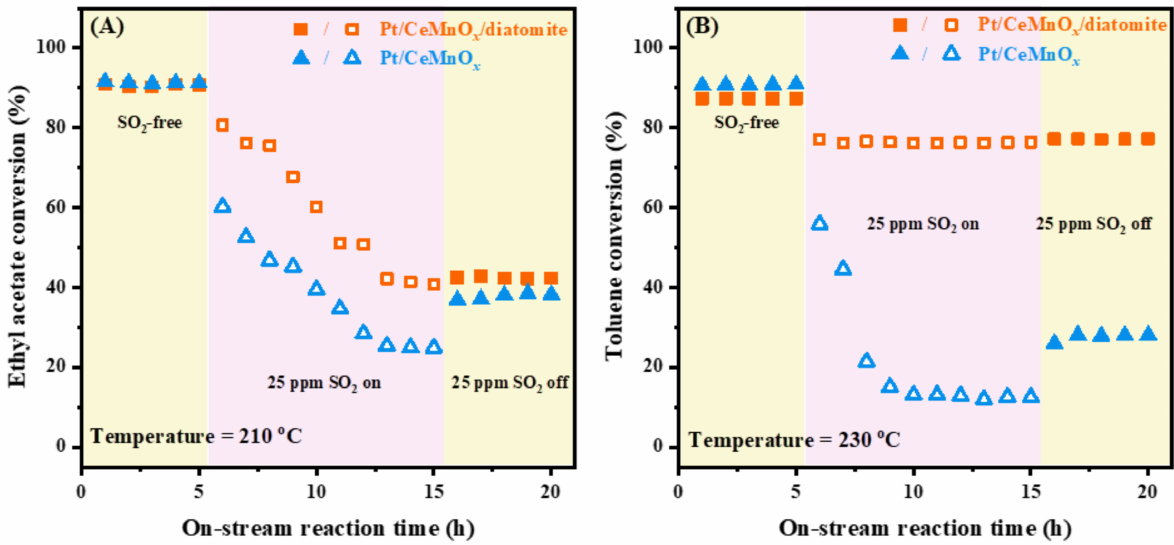
Figure 10. Effect of 25 ppm SO 2 on catalytic activity of Pt/CeMnO x /diatomite and Pt/CeMnO x for ( A ) ethyl acetate oxidation at 210 ◦ C or ( B ) toluene oxidation at 230 ◦